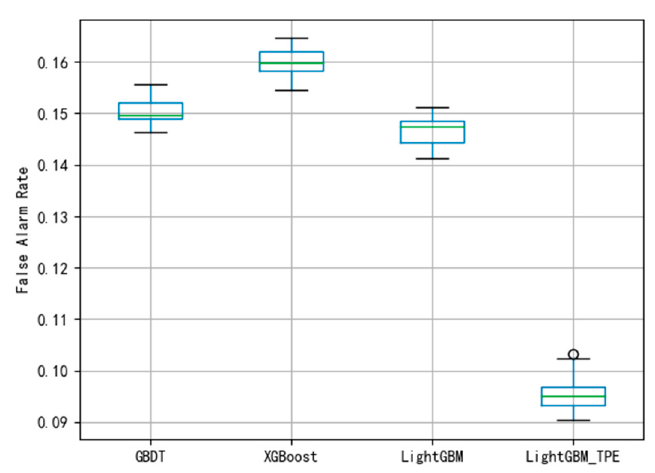
Figure 10. False alarm rates of four algorithms for fault detection of wind turbines gearboxes on dataset 3.